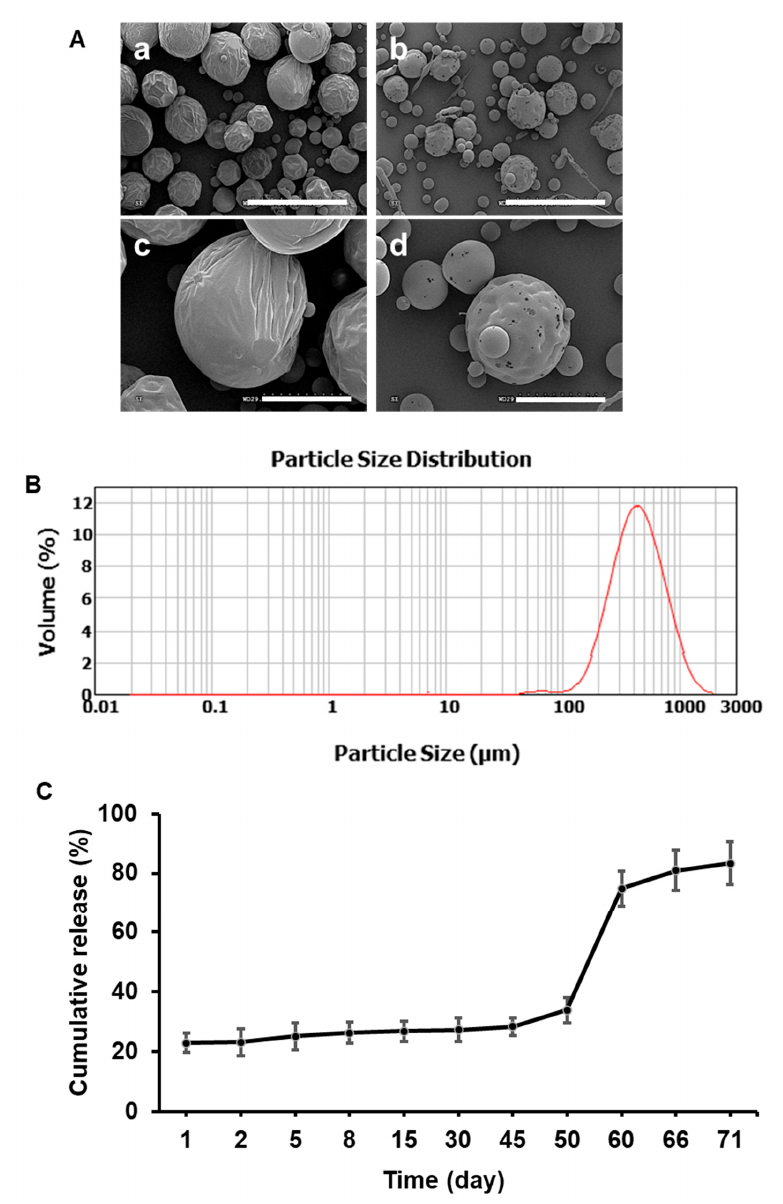
Figure 3. Morphology of the polymer-only and MTX-loaded PLGA + MePEG-diblock microspheres and extended-release profile in vitro. ( A ) Empty ( a , c ) and MTX-loaded PLGA 75% + MePEG-diblock ( b , d ) microspheres are spherical. High magnification shows that MTX-loaded microspheres have small holes on the surface. Scale bar = 1mm in ( a , b ) and 300 µ m in ( c , d ). ( B ) Representative graph of particle size distribution of the MTX (5%) loaded PLGA 75% + 20% MePEG-diblock microspheres. ( C ) Extended-release profile of PLGA + MePEG-diblock microspheres showed low initial burst release, followed by a gradual release after 40 days. A second burst release happened over 10 days between days 50 and